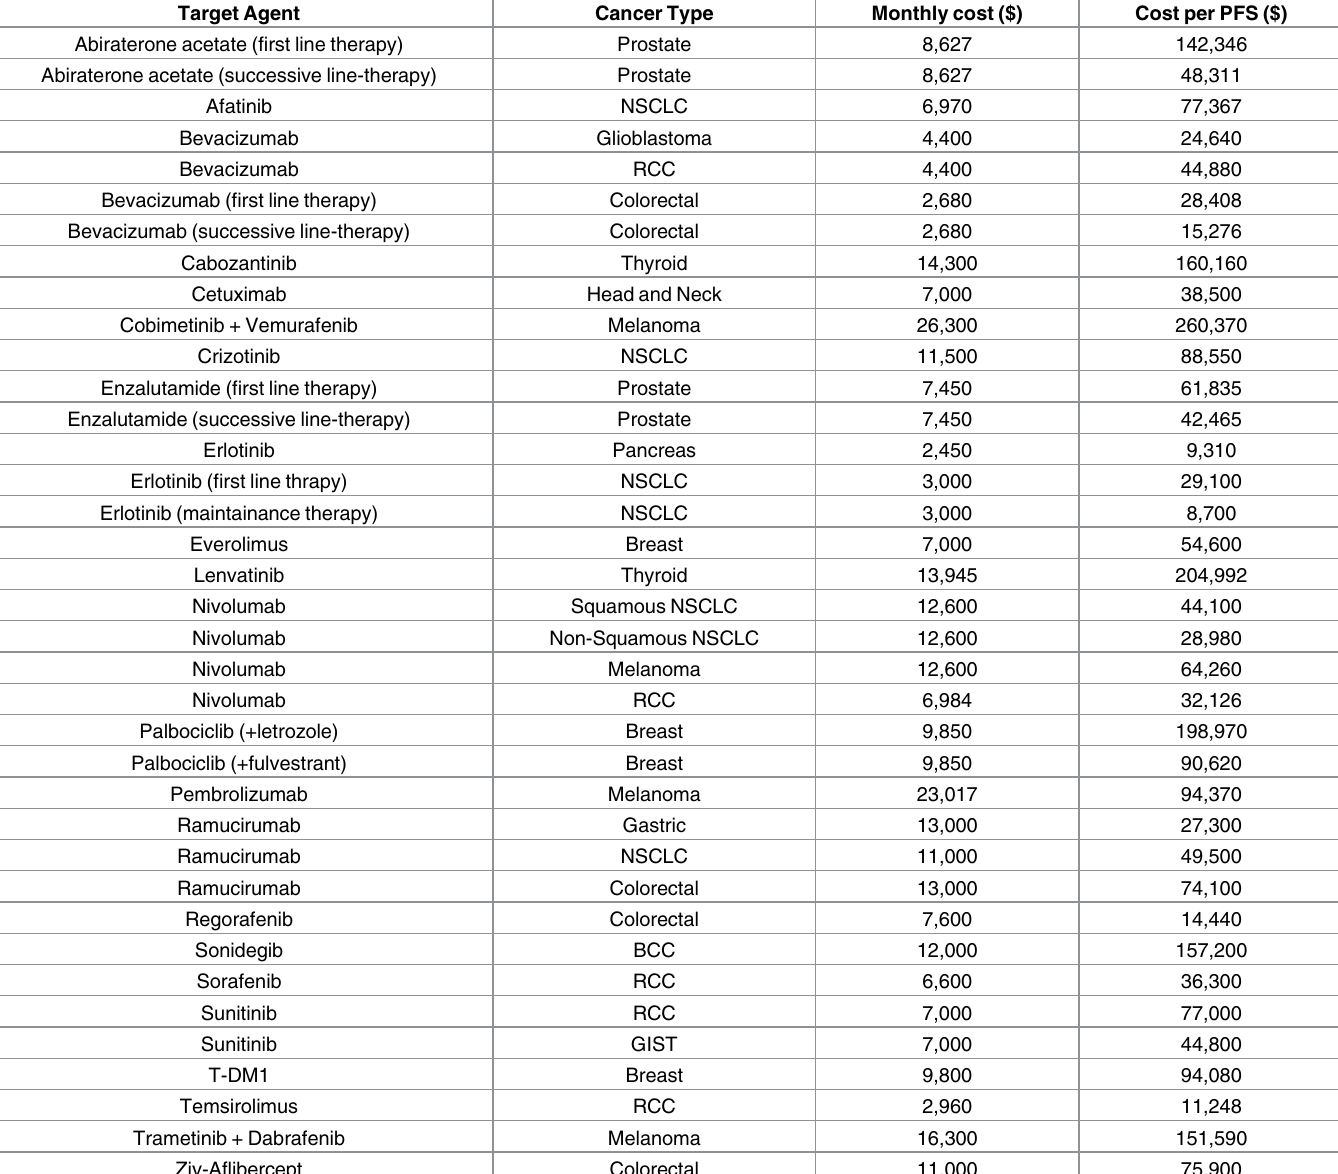
Table 3. List of target agents approved for their use in cancer patients and related costs. BCC = Basal-cell Carcinoma; GIST = Gastrointestinal Stro- mal Tumor; NSCLC = Non Small Cell Lung Cancer; RCC = RenalCell Carcinoma. Target